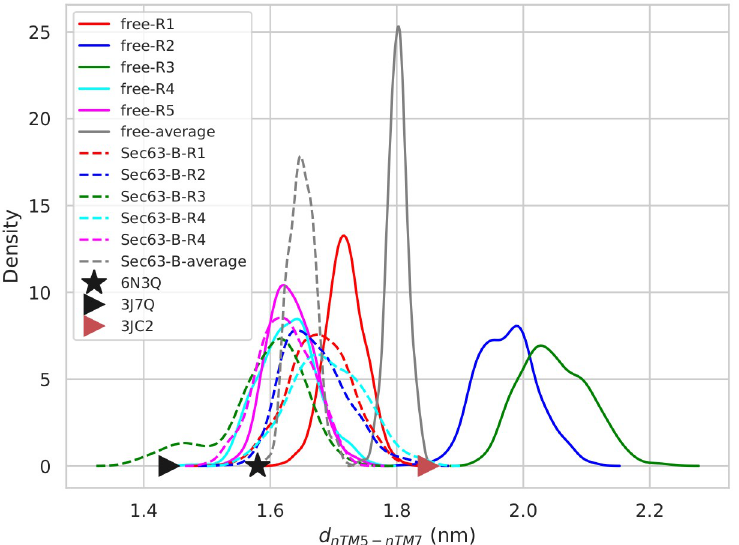
Fig 9. The probability distributions of d values obtained from the last 50 ns of five MD simulation nTM 5– nTM 7 replicas (Ri, i = replica number). Solid and dashed lines represent ‘free’ (free; without Sec63) and ‘Sec63-B’ (Sec63-bound) states, respectively. Black star, black triangular and red triangular symbols represent the values in the experimental cryo-EM structures of Sec complex, idle-state ribosome-Sec61 complex and open-state ribosome-Sec61 complex,